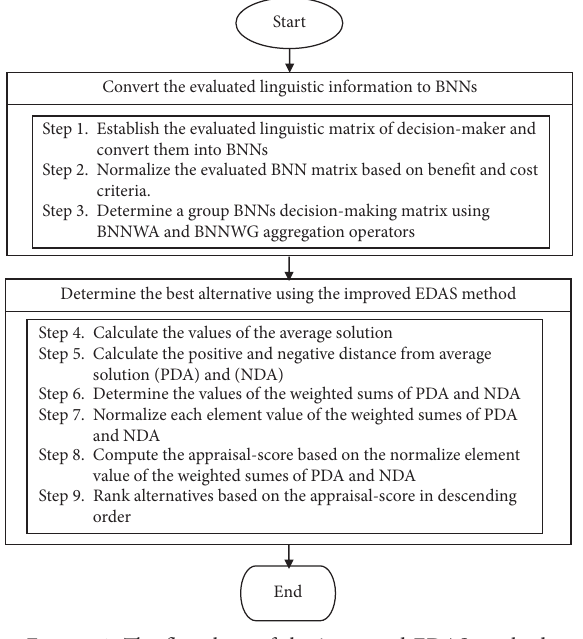
Figure 1: The flowchart of the improved EDAS